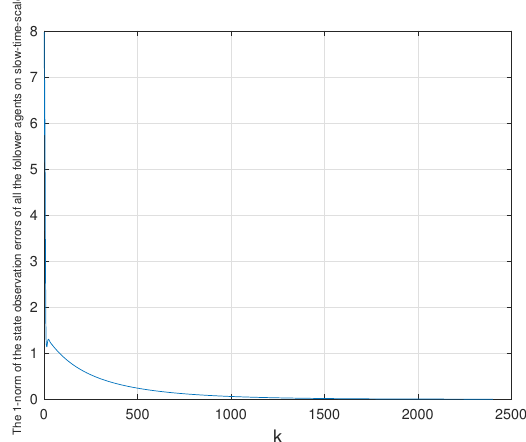
Figure 7. The 1-norm of the state observation errors of all the follower agents on slow-time